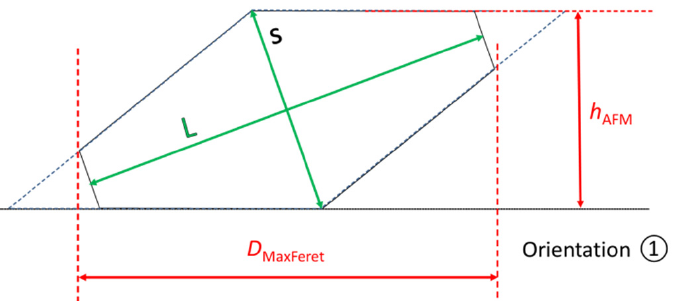
Figure 13. Schematic view of a truncated TiO 2 NPs oriented ① , with various descriptors annotated. For the TiO 2 NPs oriented 1 (cid:13) the parameter L is determined from the maximum value of measured D fmax as a function of the tilting angle, i.e., the longest D fmax can be found at that tilt at which the long axis of the particle becomes perpendicular to the electron